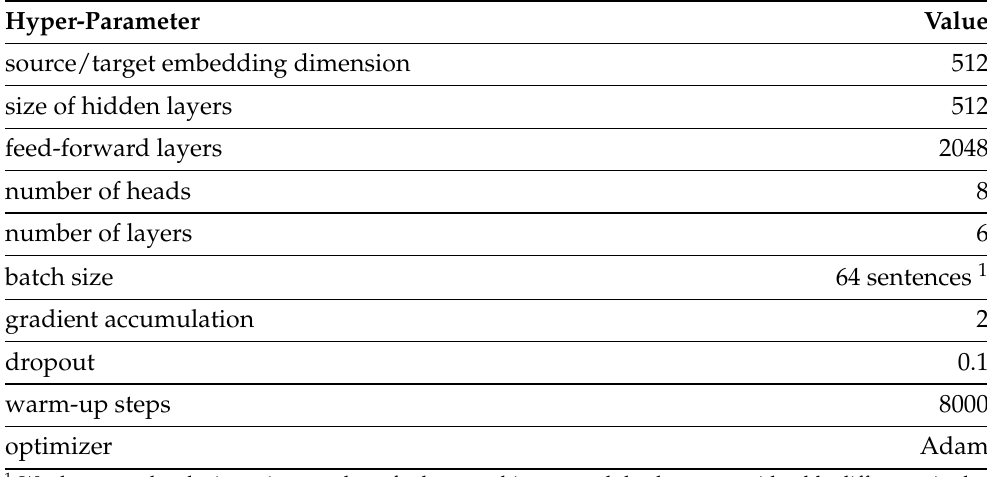
Table A2. Hyper-parameters for training NMT models.